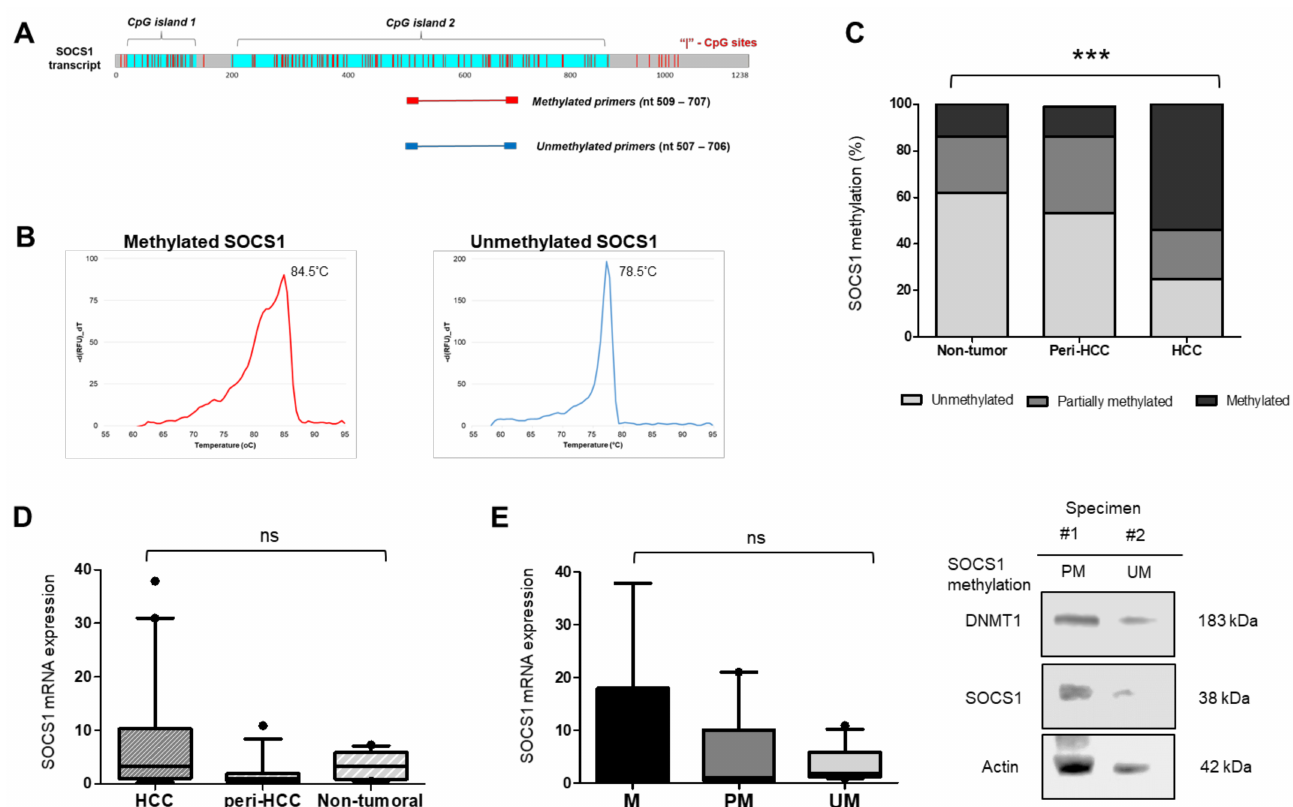
Figure 1. The identification of SOCS1 methylation status in HCC clinical specimens. ( A ) The target region of SOCS1 methylation analysis is located in CpG island 2 of SOCS1 transcript (NM_003745.2). MS-PCR primers pairs were designed by MethPrimer 2.0 Primer Design© web tool. (B) The melting curve graph of MS-PCR detects specific melting peaks of methylated-specific and unmethylated-specific SOCS1 primers (M = 84.5 ◦ C; UM = 78.5 ◦ C). ( C ) Distribution of SOCS1 methylation status showing a high incidence of methylated SOCS1 among HCC tissues and unmethylated SOCS1 in peritumoral and non-tumoral tissues. Data was presented in % value. Statistical analysis: *** p < 0.001 Chi-square test for all the variables in the graph. ( D ) Distribution of SOCS1 mRNA expression among different tissue samples analyzed by quantitative RT-PCR. ( E ) No correlation between SOCS1 methylation status and mRNA expression (PCR-based analysis, left). Representative blots of clinical specimens of DNMT1 (183 kDa) and SOCS1 (38 kDa) proteins in relation to SOCS1 methylation status (protein blot, right). MS-PCR: methylation-specific polymerase chain reaction; M: methylated SOCS1 ; PM: partially methylated SOCS1 ; UM: unmethylated SOCS1 ; ns: not